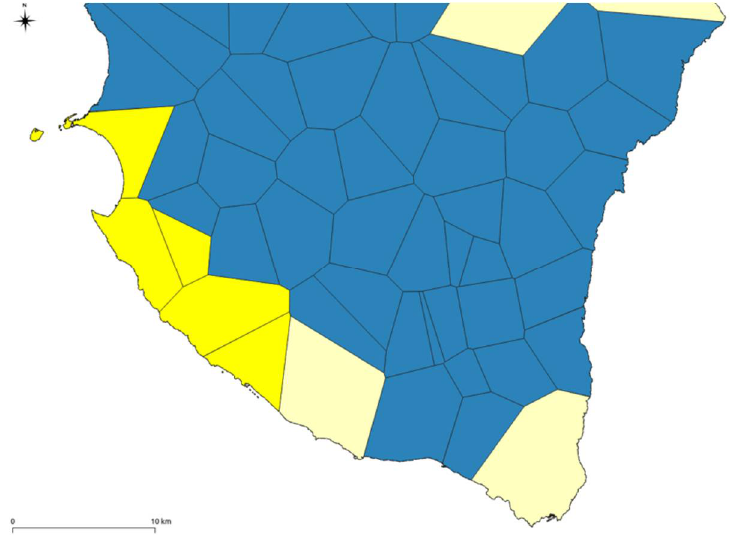
Figure 6 . Selection example of polygons where wells resulted polluted from nitrates of agricultural origin.